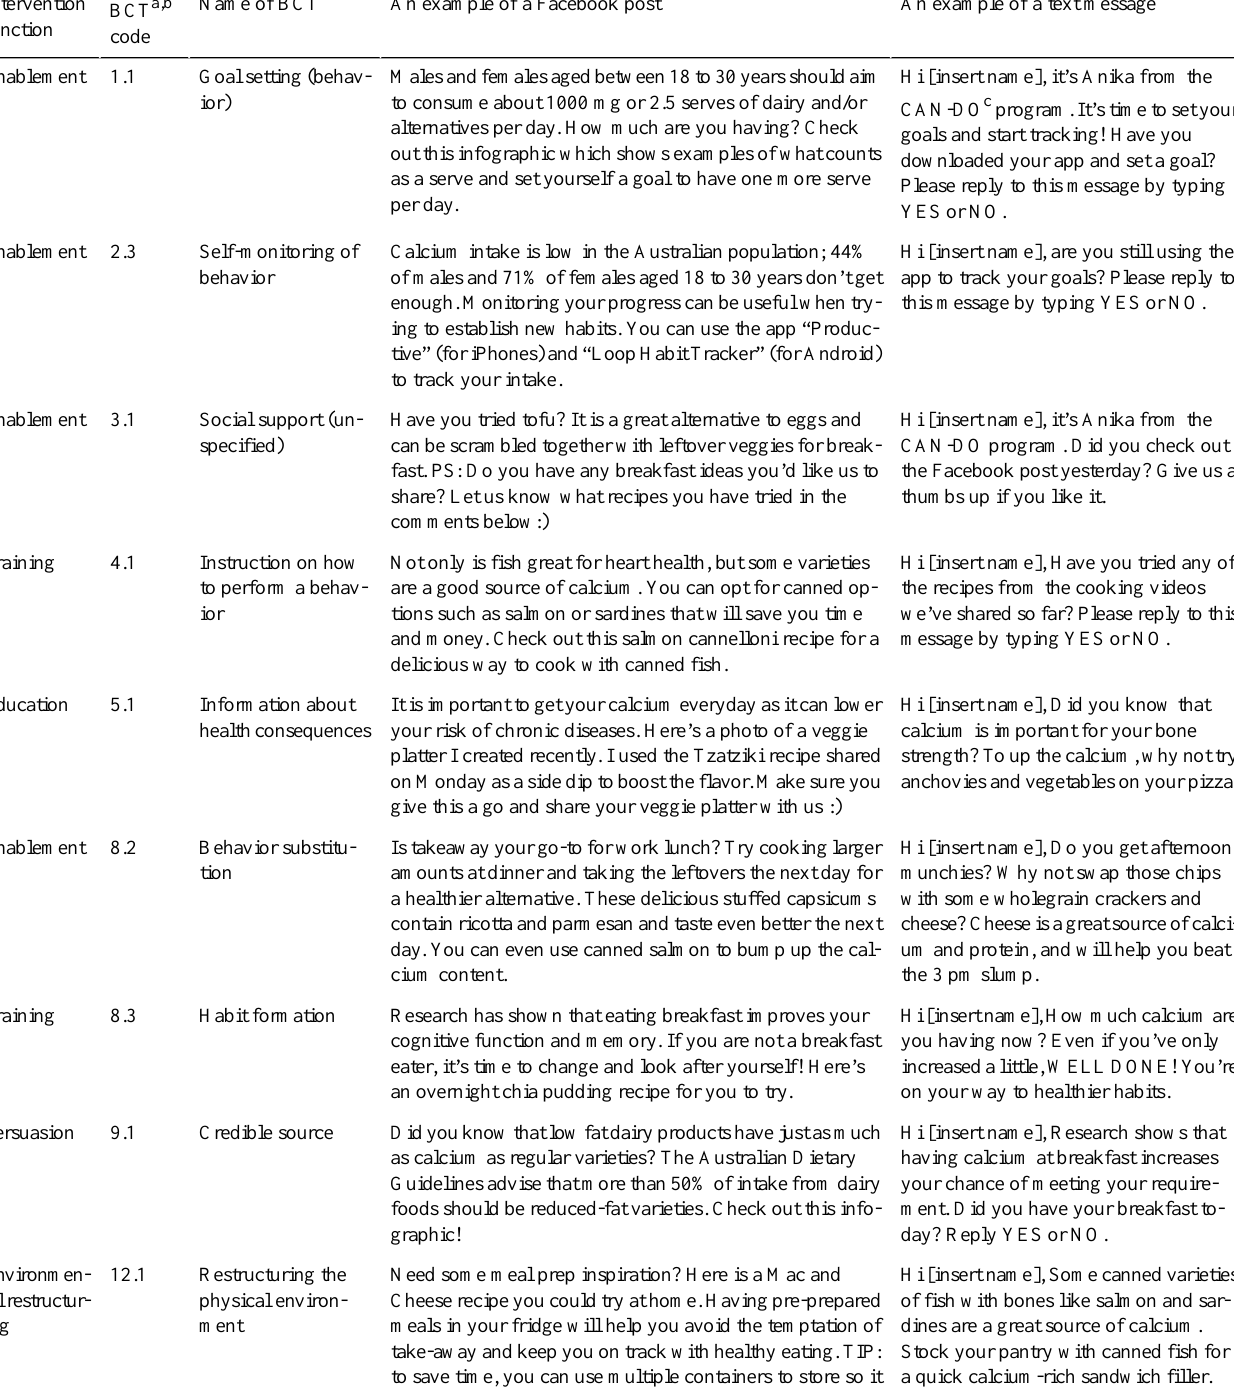
Table 1. Details of behavior change techniques with an